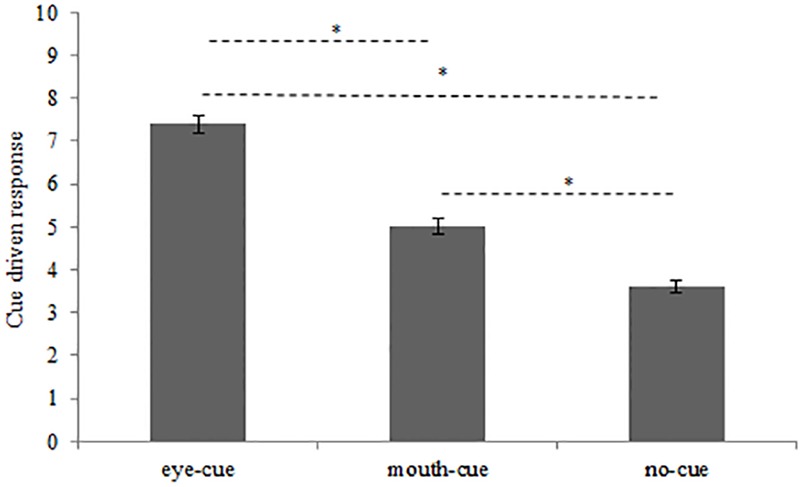
Number of chimeric facial expressions recognitions driven by eye-cue, mouth-cue, and no-cue. ∗p < 0.001; error bars depicted SE.